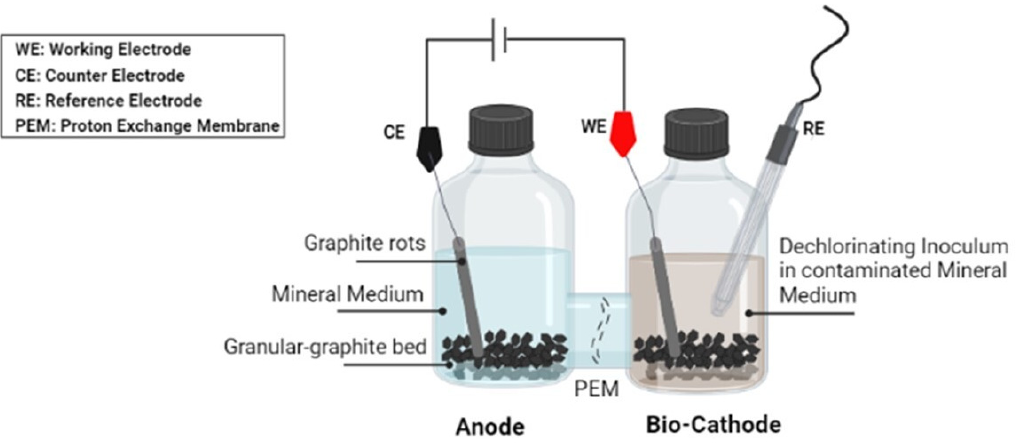
Figure 2. The schematic draw of the “Biotic H-cell” reactor.